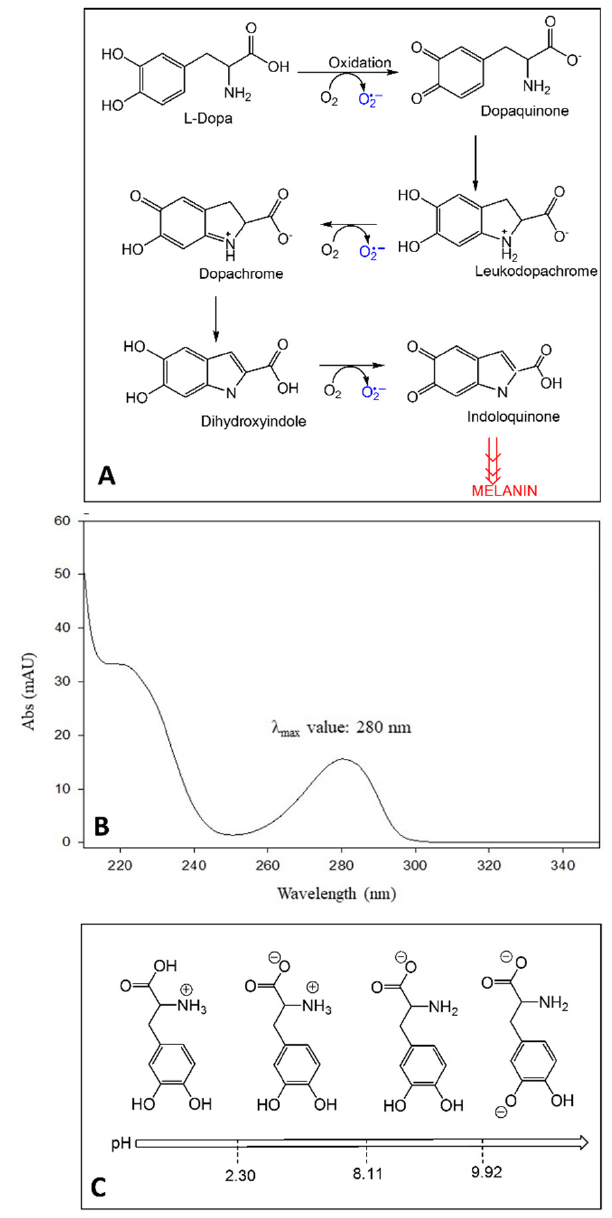
Figure 1. Auto-oxidation reactions of LD and ROS production ( A ); UV absorption spectrum of LD ( B ); LD structures at different pH and corresponding pKa values ( C ).